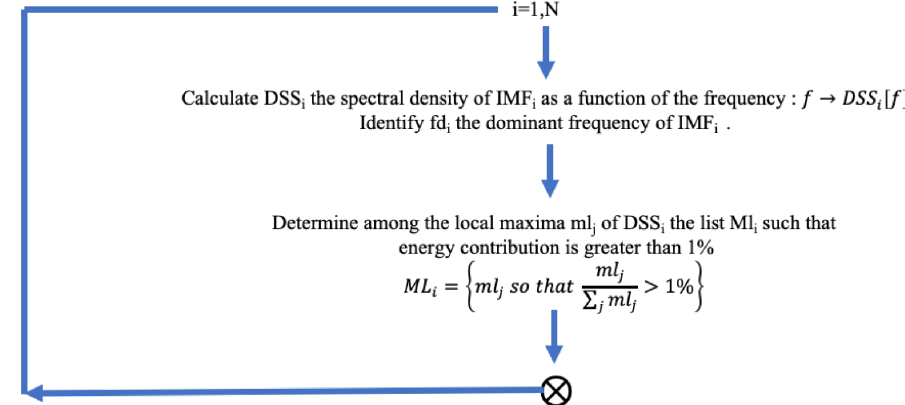
Figure 1. Estimation of the spectral density for each IMF spectrum and selection of significant local maxima whose energy contribution > 1%.